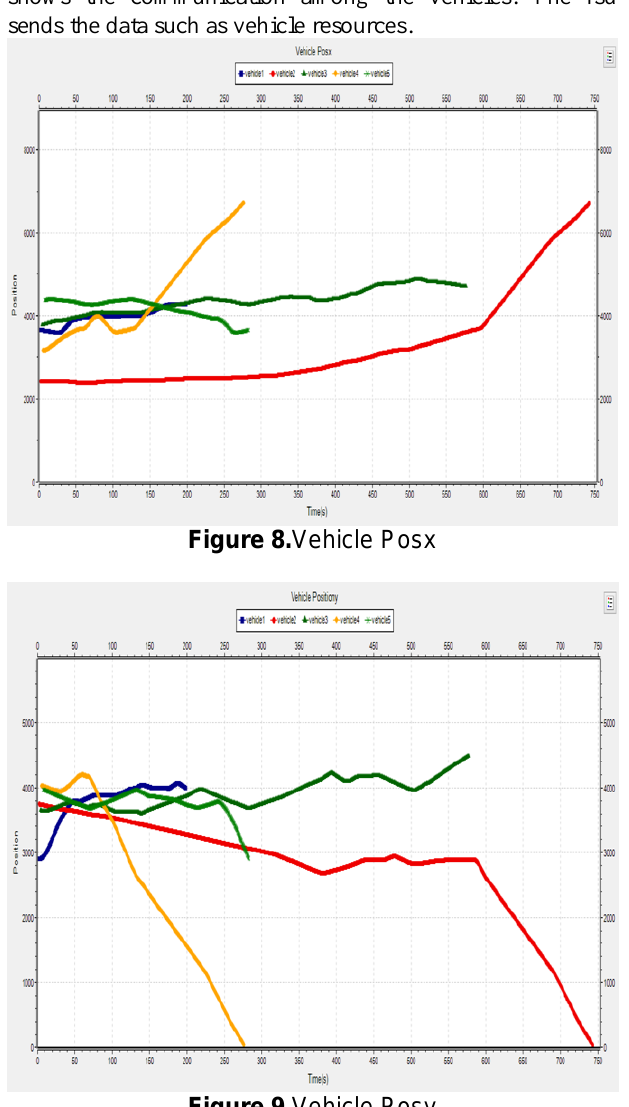
Figure 9 .Vehicle Posy